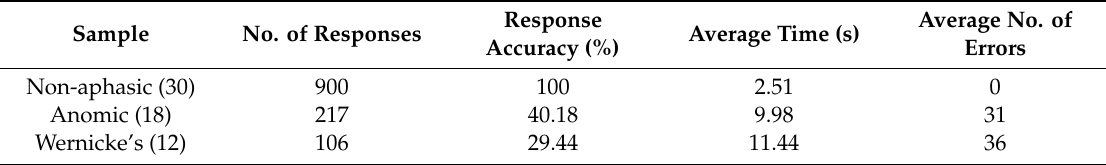
Figure 4. Confrontation naming performance of the non-aphasic, Anomic, and Wernicke’s subjects. ( a ) Mean time taken to elicit words in the comprehension task; ( b ) formant frequency variation; ( c ) speech characteristics identified in aphasic subjects. Table 2. Performance analysis summary of confrontation naming